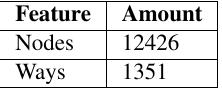
Table 5. Mapping results of the fourth course meeting.